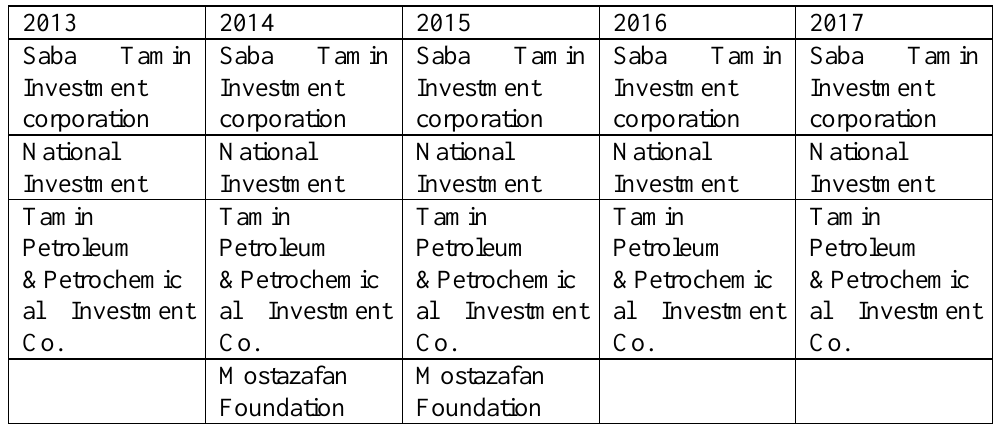
Table 4. Shareholders related to the maximum degree